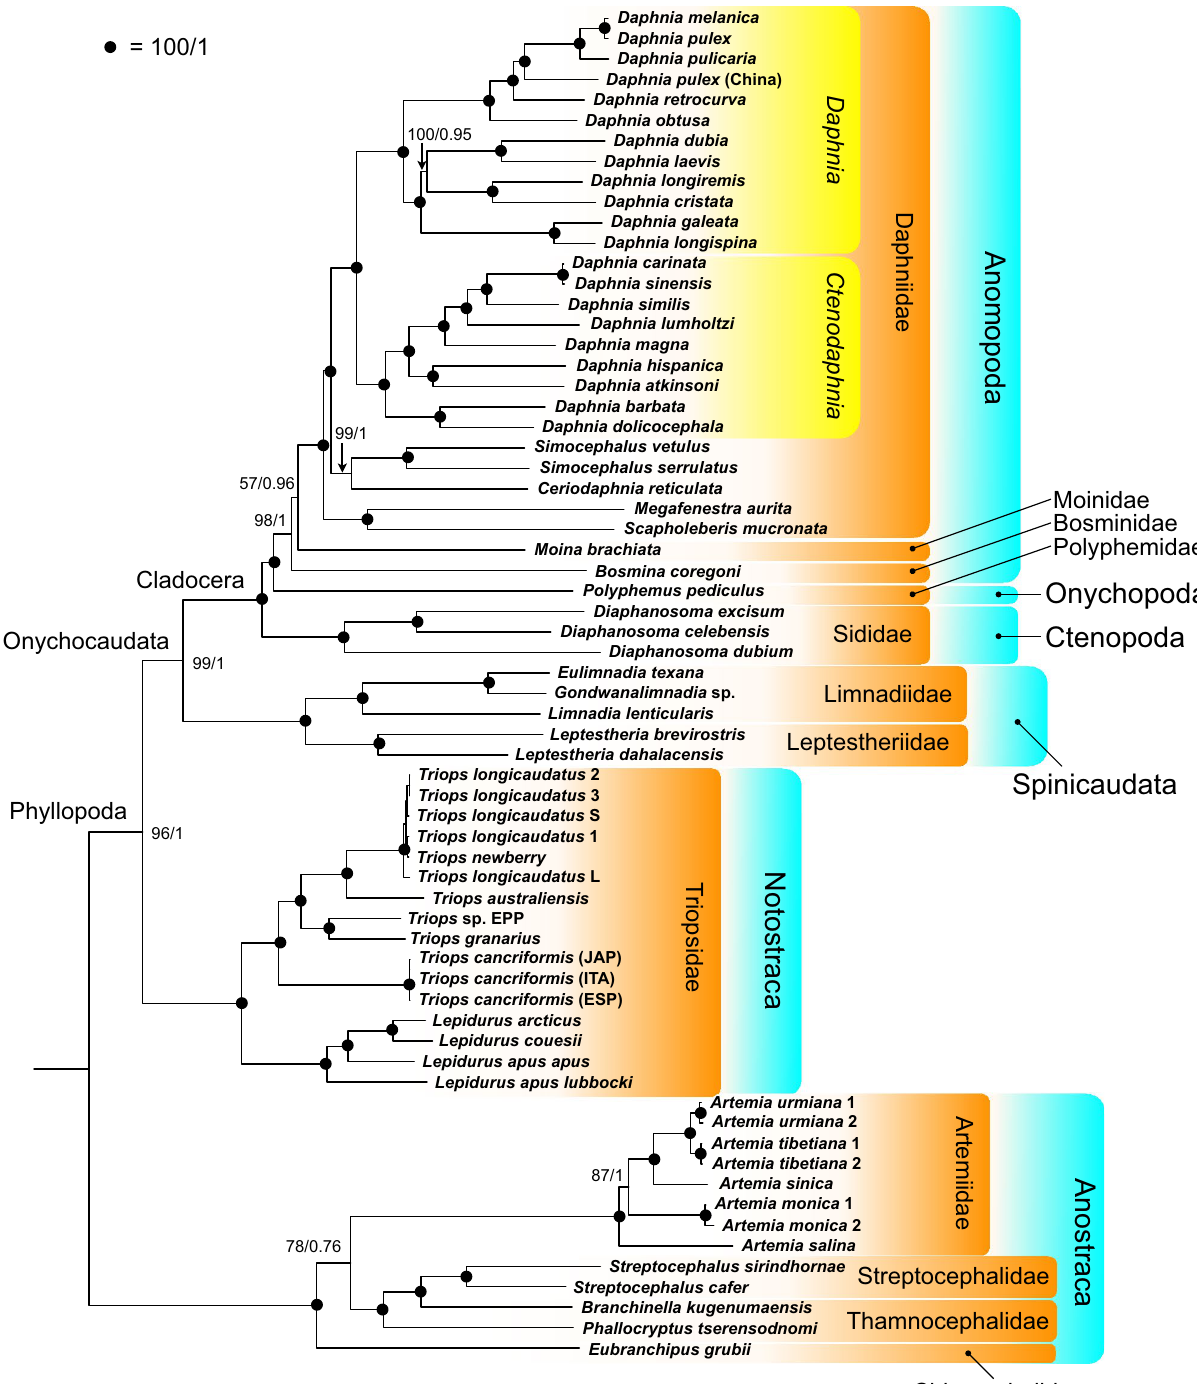
Figure 1. Maximum likelihood phylogenetic tree (− lnL = 446,363.518) built on the nucleotide alignment of the 13 mitochondrial protein-coding genes (including 3rd codon positions) + the two rRNA genes using IQTREE. Numbers at nodes represent bootstrap proportion/bayesian posterior probability; full circles indicate maximum nodal support as per upper left